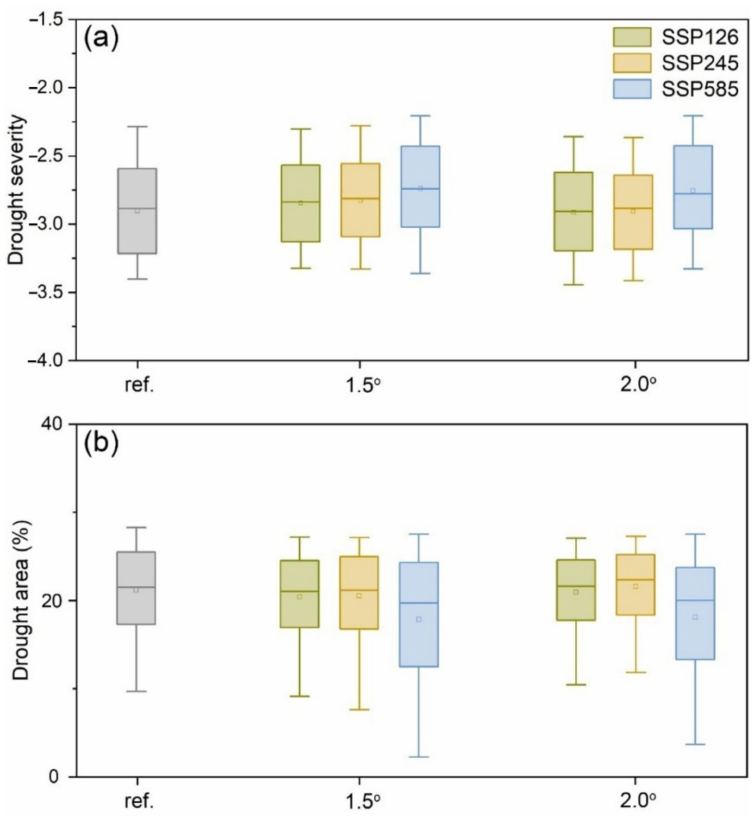
Figure 3. Drought severity ( a ) and drought area ( b ) in China for the reference period (1995–2014) and the 1.5 ◦ C/2.0 ◦ C global warming periods under SSP1 − 2.6, SSP2 − 4.5, and SSP5 −